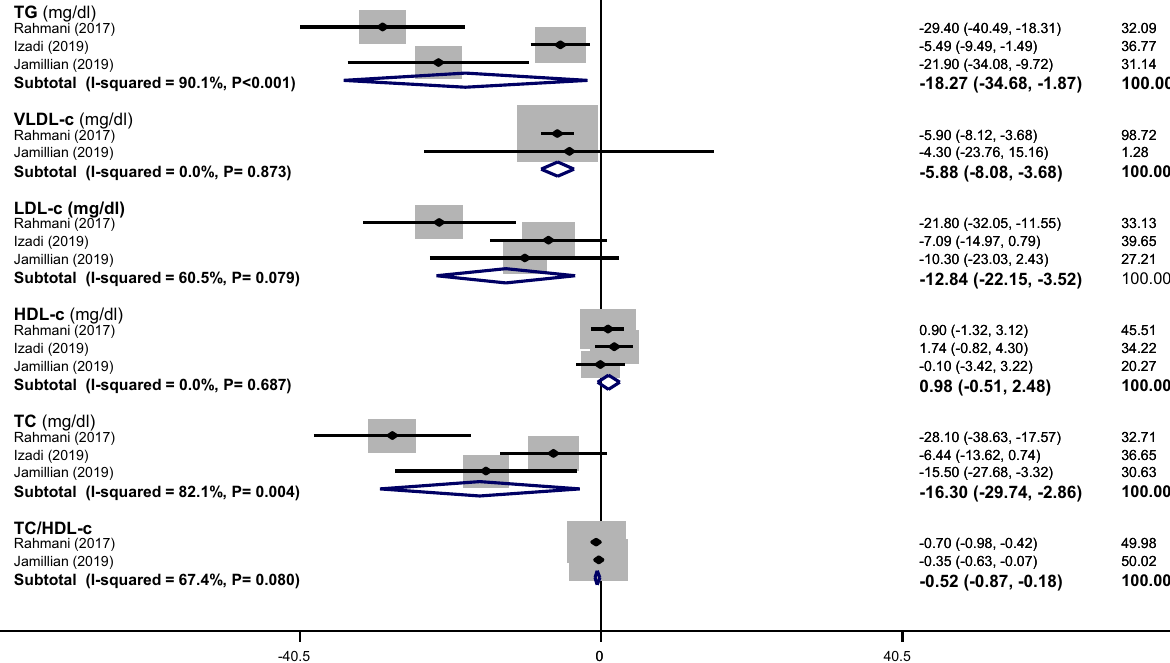
Figure 2. Forest plots of the effect of vitamin E supplementation or vitamin E along with omega-3 or magnesium supplementation on lipid profile. If the diamond does not touch the vertical line (or the line of null effect), the overall effect is statistically significant. Significant reductions were found in serum levels of TG (WMD: − 18.27 mg/dL, 95% CI − 34.68 to − 1.87), VLDL (WMD: − 5.88 mg/dL, 95% CI − 8.08 to − 3.68), LDL-c (WMD: − 12.84 mg/dL, 95% CI − 22.15 to − 3.52), TC (WMD: − 16.30 mg/dL, 95% CI − 29.74 to − 2.86) and TC /HDL-c ratio (WMD: − 0.52, 95% CI − 0.87 to − 0.18) in PCOS patients after vitamin E supplementation or vitamin E along with omega-3 or magnesium supplementation in comparison to